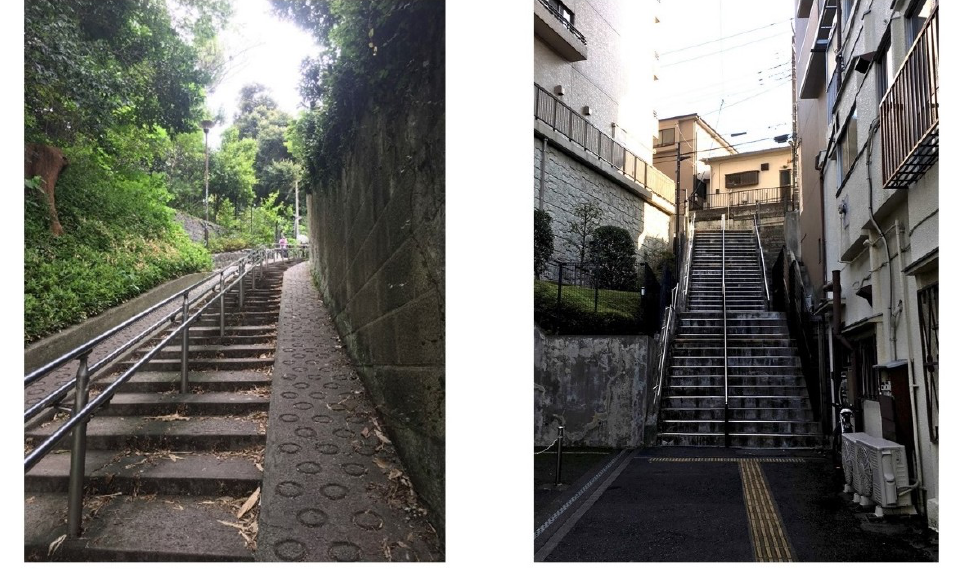
Figure 1. Steep slopes in the central parts of Tokyo, Japan (source: authors).